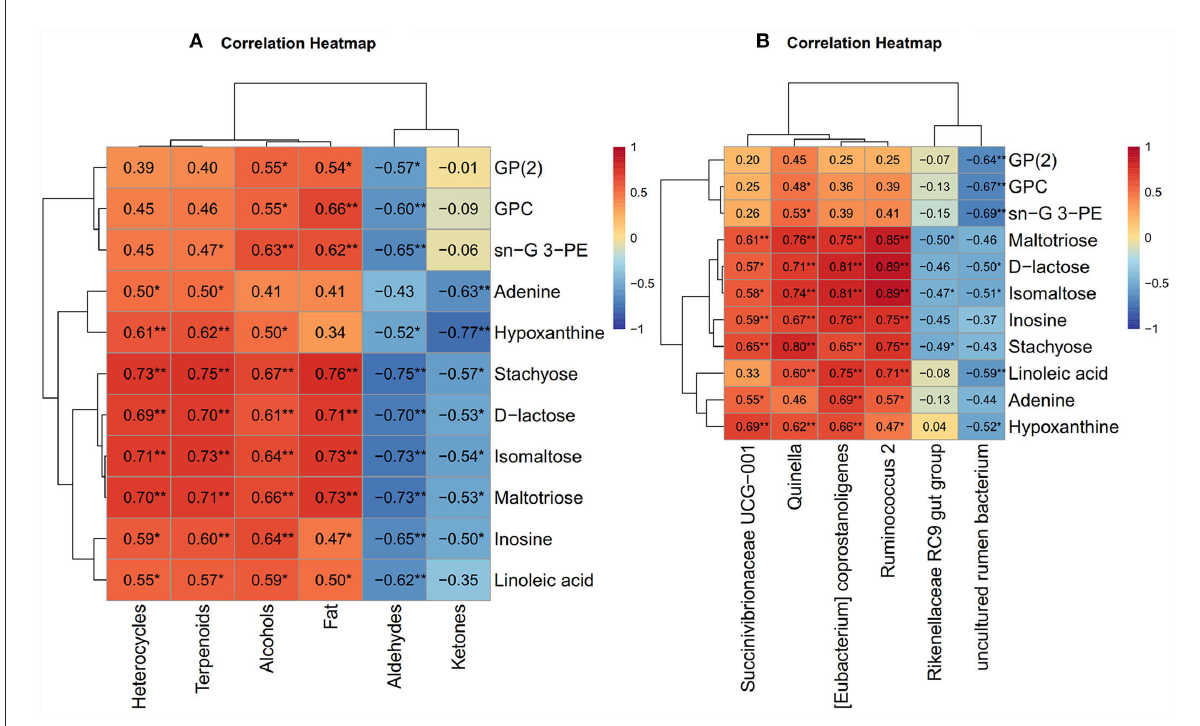
FIGURE6 (A ) The correlation heat map between meat quality parameters and muscle metabolomics analysis. (B) The correlation heat map between muscle metabolomics analysis and rumen bacteria. The color red and blue represent positive and negative correlations, respectively. * P < 0.05 and ** P < 0.01. G: glycerol; PE: phosphoethanolamine; GP(2): glycerophosphate(2); GPC: